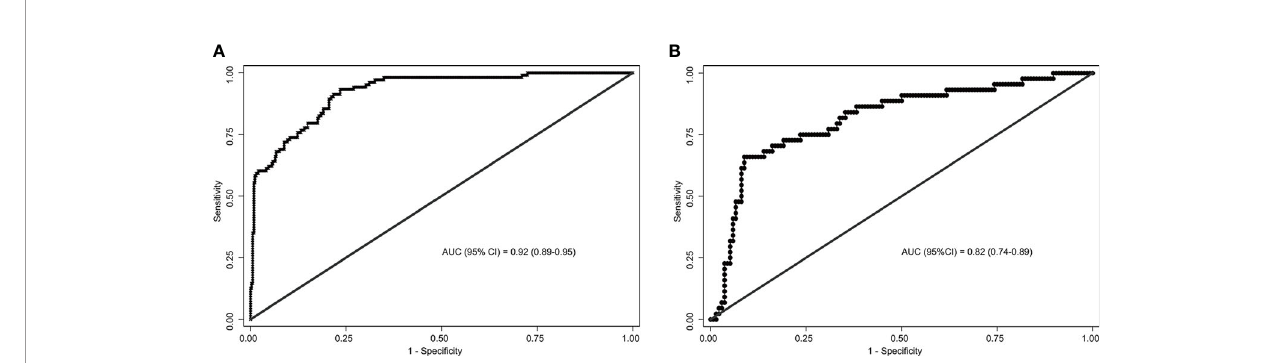
FIGURE 4 | Receiver operating characteristics (ROC) curves of the nomograms in training and validation cohort. (A) The ROC curve of the training cohort; (B) The ROC curve of the validation cohort. The nomogram had a good discriminative performance with Area under ROC curve (AUC) (95% con fi dence interval) of 0.92 (95% CI: 0.89-0.95) and 0.82 (95% CI: 0.74-0.89) in the training and validation cohort, respectively. TABLE 4 | Accuracy of the prediction score of the nomogram for estimating the risk of SLN metastasis. Variables P Value (95% CI)